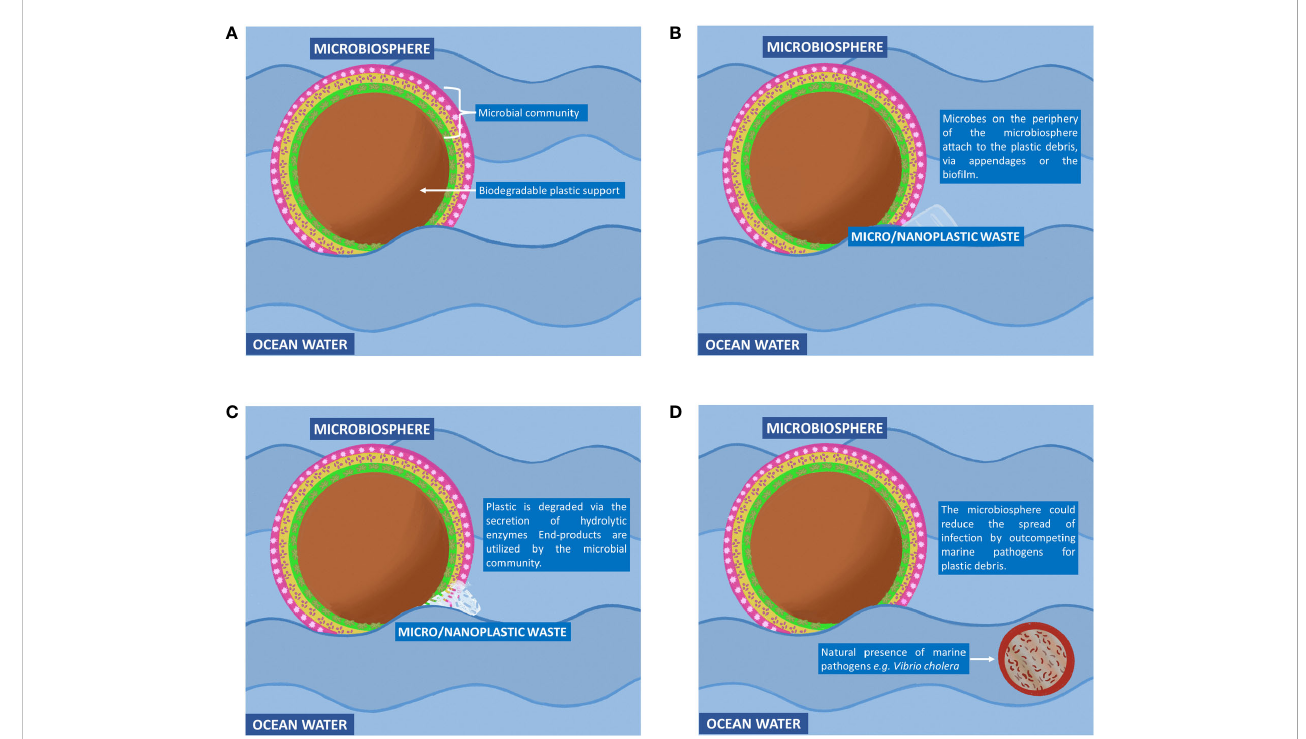
FIGURE 2 The concept of the microbiosphere. (A) A biodegradable solid support (central brown circle) would be used to accommodate a rationally engineered community of microbial species known as the microbiosphere. This community would include phototrophic and heterotrophic species to ensure self- sustainability (green, orange and pink areas). A solid support would be critical for transporting the microbiosphere across the ocean as well as providing nutrients to the microbiosphere. (B) Micro- and nanoplastic waste that is too small to be fi ltered off and collected by conventional technologies could potentially cause harm to marine life, as well as humans. To remove these small plastic waste particles, microbiospheres would be released into the ocean. These biological entities would attach themselves to micro- and nanoplastic waste debris with the aid of cellular appendages and the adhesive property of the community bio fi lm. (C) Hydrolytic enzymes would be secreted into the extracellular environment to break down the plastic polymer into its monomers. The monomers would be taken up by microbial cells via protein transporters and converted to metabolites that support the growth and survival of the microbiosphere. (D) By outcompeting pathogenic microbial species (small circle outlined in brown) for the plastic waste, the microbiosphere could potentially reduce the risk of infectious